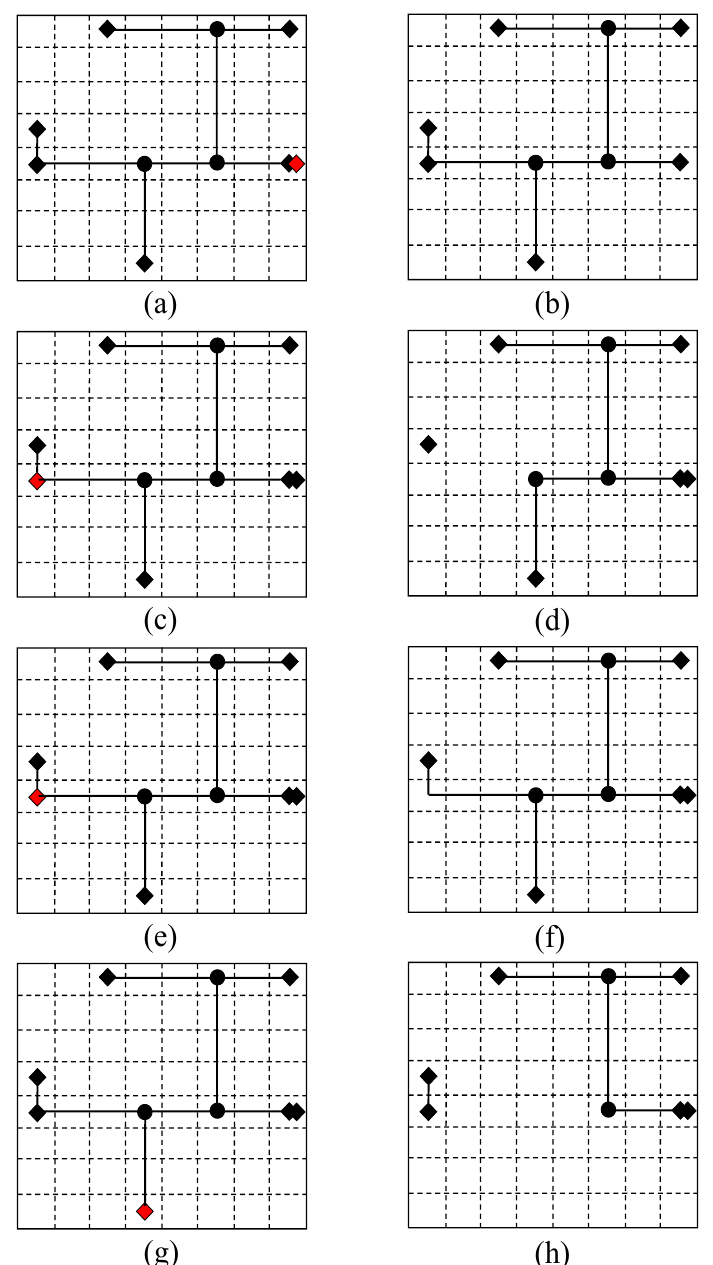
Figure 4. Four rip up cases considered in our flow. The diamond and circle represent the pin and the Steiner point, respectively. The pin to be removed is marked in red, and the grid in the lower left corner is (0, 0). ( a ) Grid (7, 3) contains a removed pin. ( b ) The remaining path and pin for the case R 1. ( c ) Grid (0, 3) contains a removed pin. ( d ) Delete paths until reaching a grid that contains a pin or a Steiner point for the case R 2. ( e ) Grid (0, 3) contains a removed pin whose degree is two. ( f ) Ensure the connectivity of the remaining path for the case R 3. ( g ) Grid (3, 0) contains a removed pin. ( h ) The remaining path after rip up for the case R